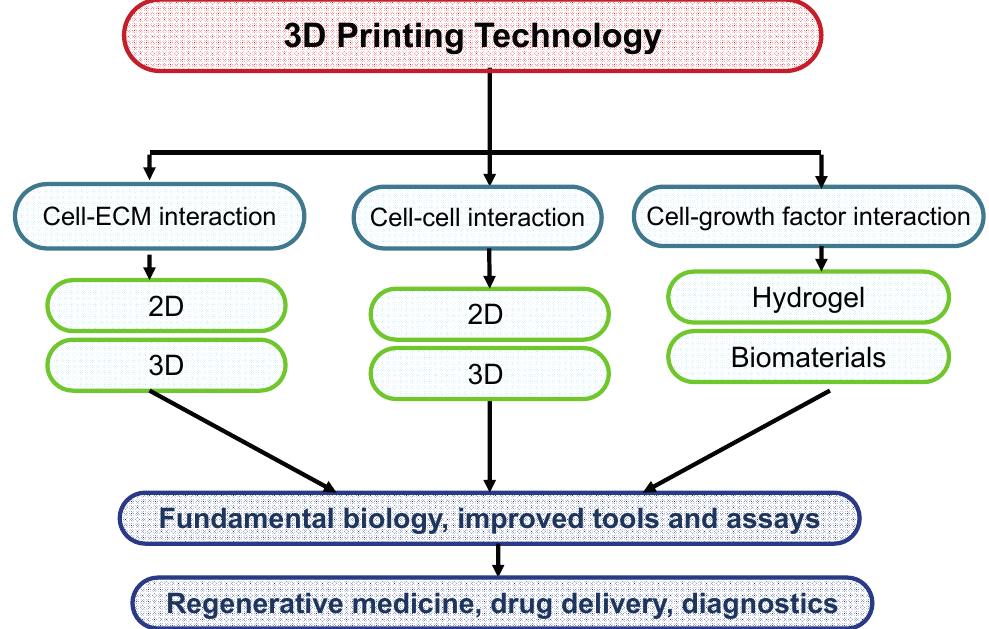
Figure 6. 3D printing technology for tissue engineering